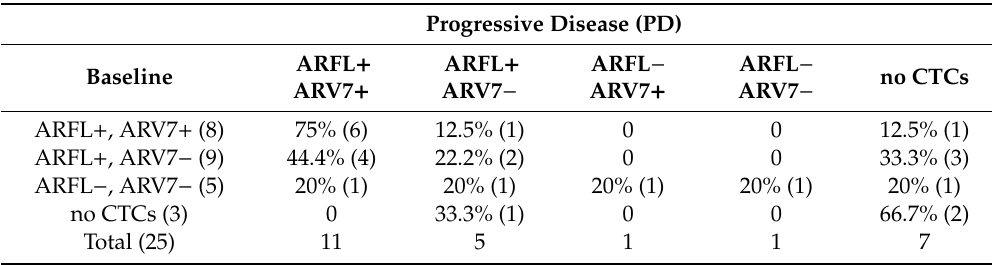
Table 5. ARFL and ARV7 conversion at PD. Percentages refer to the fraction of patients within groups who at baseline shared biomarker constellation (first column). Numbers in brackets refer to the number of patients with specific ARFL/ARV7 profile analyzed at PD.